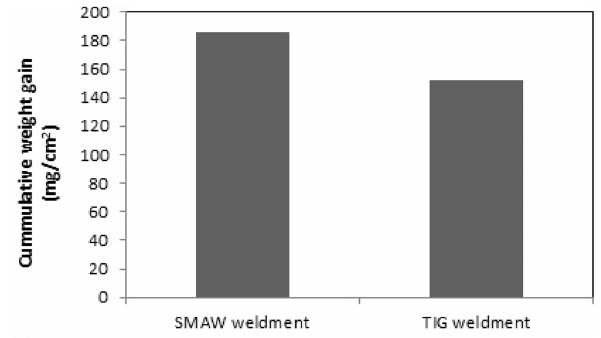
Figure 3: Cumulative weight gain of